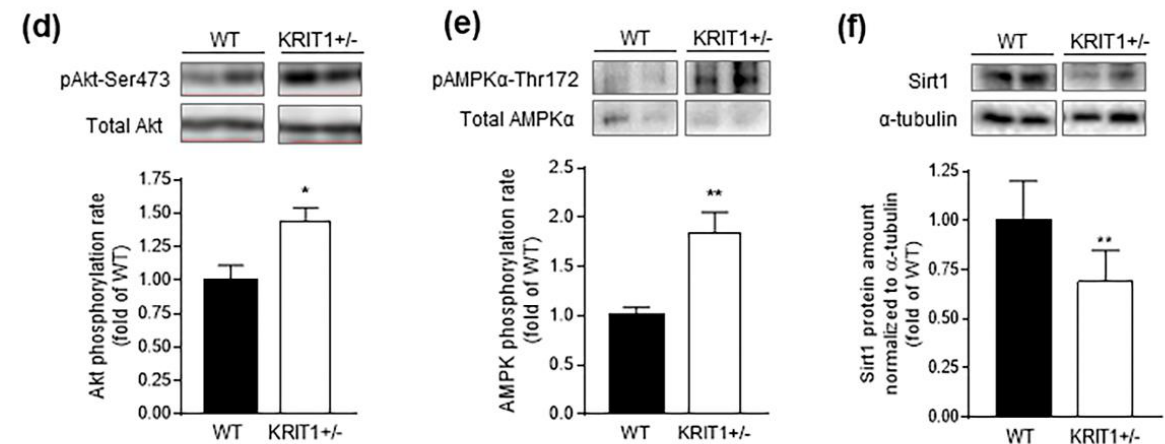
Figure 2. Heterozygous loss of KRIT1 in mice caused downregulation of FoxO1 in the liver. ( a ) Rep- resentative Western blots showing a downregulation of KRIT1 protein levels in liver homogenates from KRIT1 heterozygous (KRIT1 +/ − ) mice vs. their wild-type (WT) littermates. ( b ) Representative Western blots showing a significant downregulation of both cytoplasmic and nuclear FoxO1 expression levels in subcellular fractions of liver homogenates from KRIT1 +/ − mice vs. their WT counterparts. His- tograms represent the densitometric quantification of FoxO1 bands of 7 mice per group normalized to the corresponding α -tubulin and proliferating cell nuclear antigen (PCNA) loading controls for cytosolic and nuclear fractions, respectively. ( c ) Representative Western blots showing a significant increase in FoxO1 phosphorylation at Ser256 in whole liver homogenates from KRIT1 +/ − vs. WT mice. The histogram represents the densitometric quantification of phosphorylated FoxO1 bands of 7 mice per group normalized to the corresponding total forms. ( c – e ) Representative Western blots showing a marked increase in the activating phosphorylation of Akt/protein kinase B (pAkt-Ser473) ( d ) and AMP-activated protein kinase (pAMPK-Thr172) ( e ) serine/threonine kinases, as well as a sig- nificant downregulation of the expression level of Sirtuin 1 (Sirt1) deacetylase ( f ) in liver homogenates from KRIT1 +/ − vs. WT mice. Histograms represent the densitometric quantification of pAkt-Ser473, pAMPK-Thr172 and Sirt1 protein bands of 7 mice per group normalized to the corresponding total forms or loading control ( α -tubulin), respectively. Data are means ± SEM of 7 mice per group and are presented as fold changes relative to the WT control. * p < 0.05; ** p < 0.005 vs.